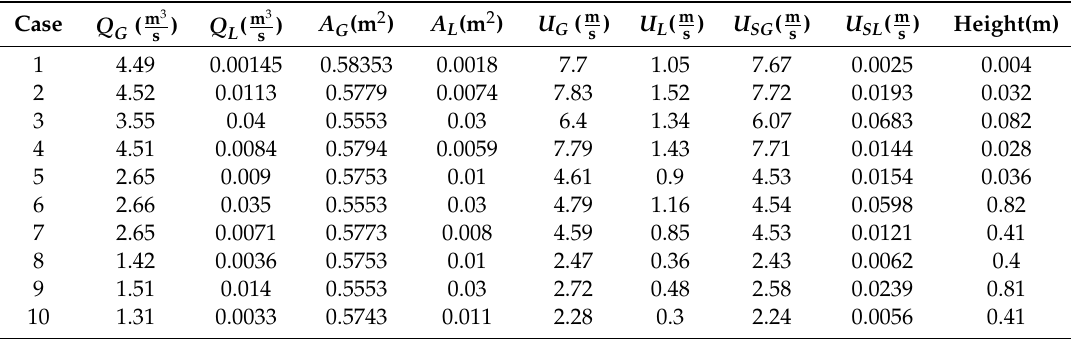
Table 3. Boundary conditions for the gas ( G ) and liquid ( L ) at the inlet for all the cases considered in this study: Q is the volumetric flow rate; A is the area occupied by each phase; U G , and U L are the velocity of the gas and liquid, respectively; U SG and U SL are the superficial velocities of the gas and liquid, respectively; and the last column shows the height of the liquid at the